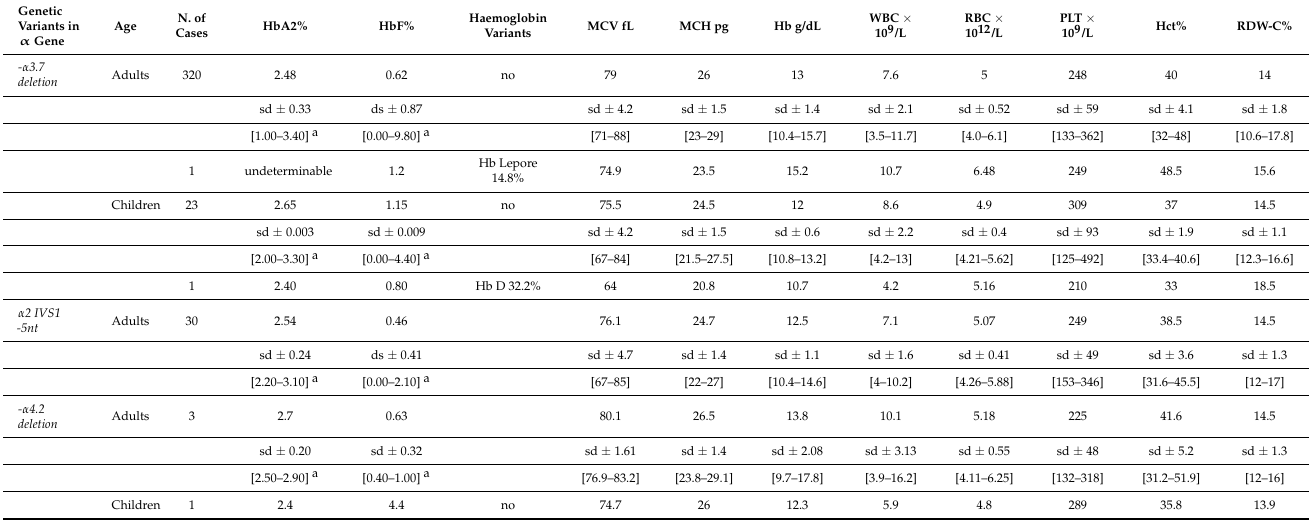
Table 3. Hematological parameters (mean values and Standard Deviation (SD)) observed in subjects with mutations in the α -globin